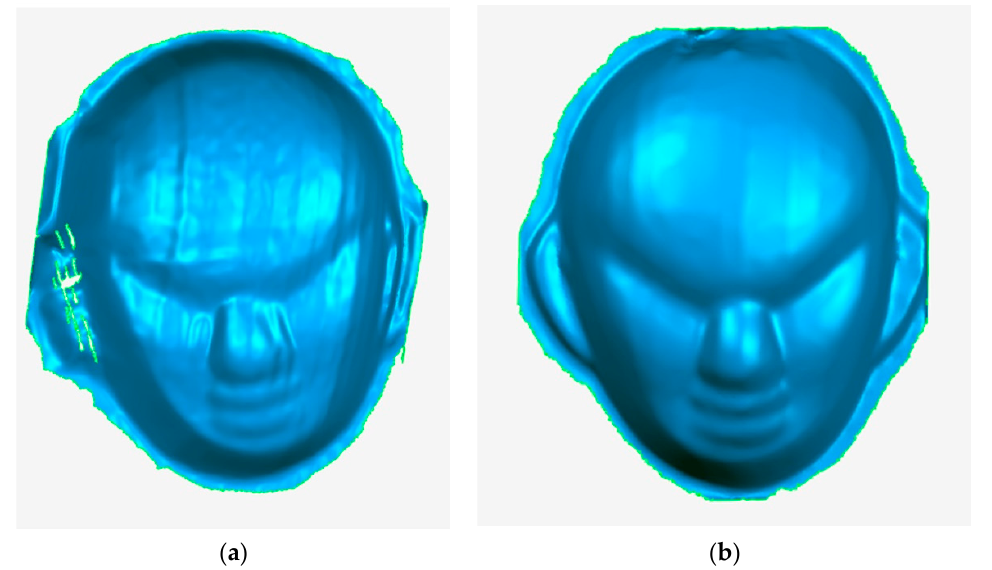
Figure 16. 3D reconstruction image. ( a ) Traditional method ( b ) The method of this paper.